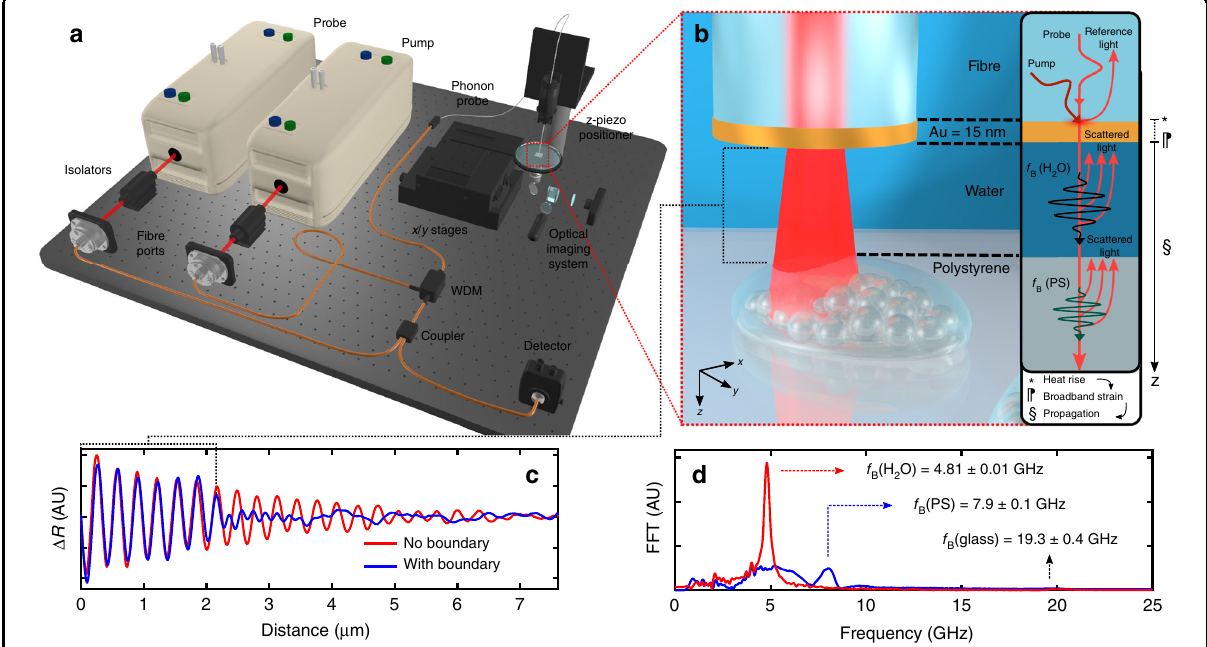
Fig. 1 Design, mechanism, and signal response of the phonon probe. a Experimental layout of the phonon probe system (further details in ‘ Materials and methods ’ ). b The phonon probe approaches a polystyrene (PS) object immersed in water. (inset) Absorption of a pump pulse heats the transducer which relaxes in the form of broadband strain (propagating away from the fi bre-tip). A probe pulse partially re fl ects at the transducer interface (reference beam), Brillouin scatters with the f B (H 2 O) mode in water (black waveform), and later in signal time (a subsequent probe pulse) Brillouin scatters with the f B (PS) mode (green waveform). Co-propagating reference and scattered light (now counter-propagating in the system) interfere at the detector, producing a modulation in re fl ectivity ( Δ R ). c The transition in materials is observed in the time/spatial domain for the blue TRBS signal (water for Δ R ( z < 2 μ m) and PS for Δ R ( z > 2 μ m)), or is unobservable if there is no object impeding the measurement volume (red curve). d Fast Fourier transform (FFT) of the TRBS signals reveals the constituent Brillouin frequencies of the respective